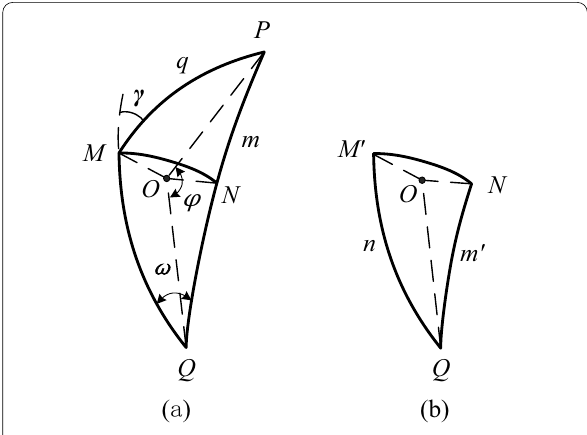
Figure 3 Schematic of spherical triangle PQM ( a ) and MNQ ( b